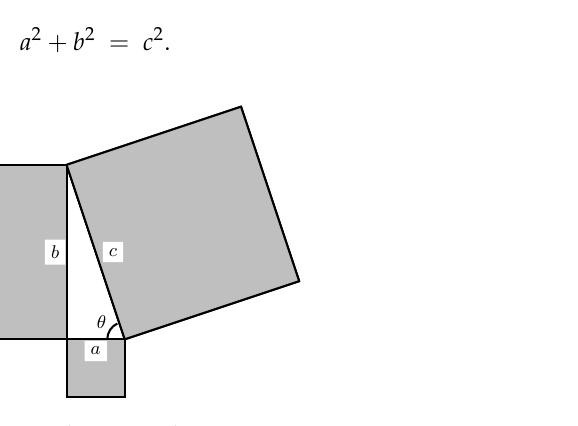
Figure 1. Pythagorean